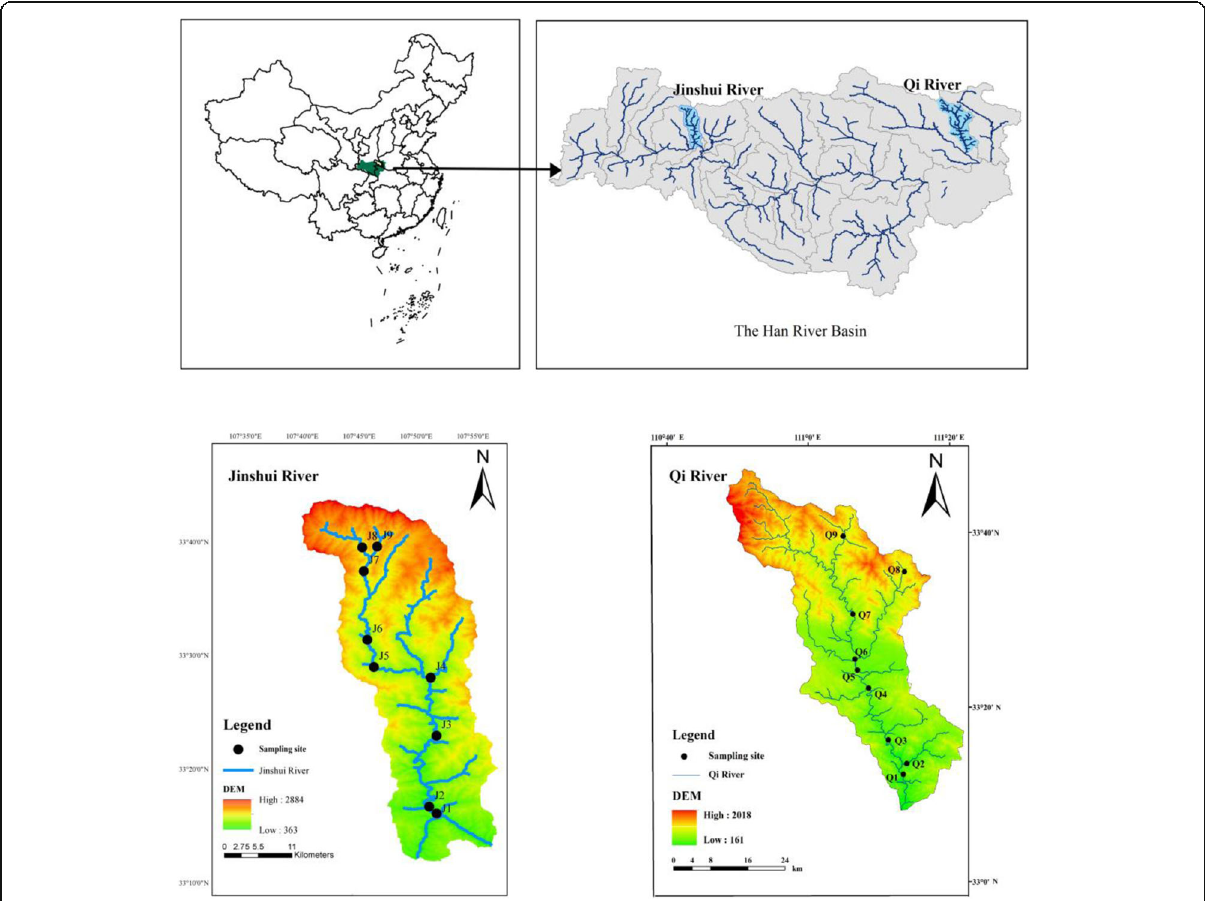
Fig. 1 Sampling sites of the Jinshui River and Qi River. The source of DEM is the free data from https://earthexplorer.usgs.gov/. The map was made in ArcGIS